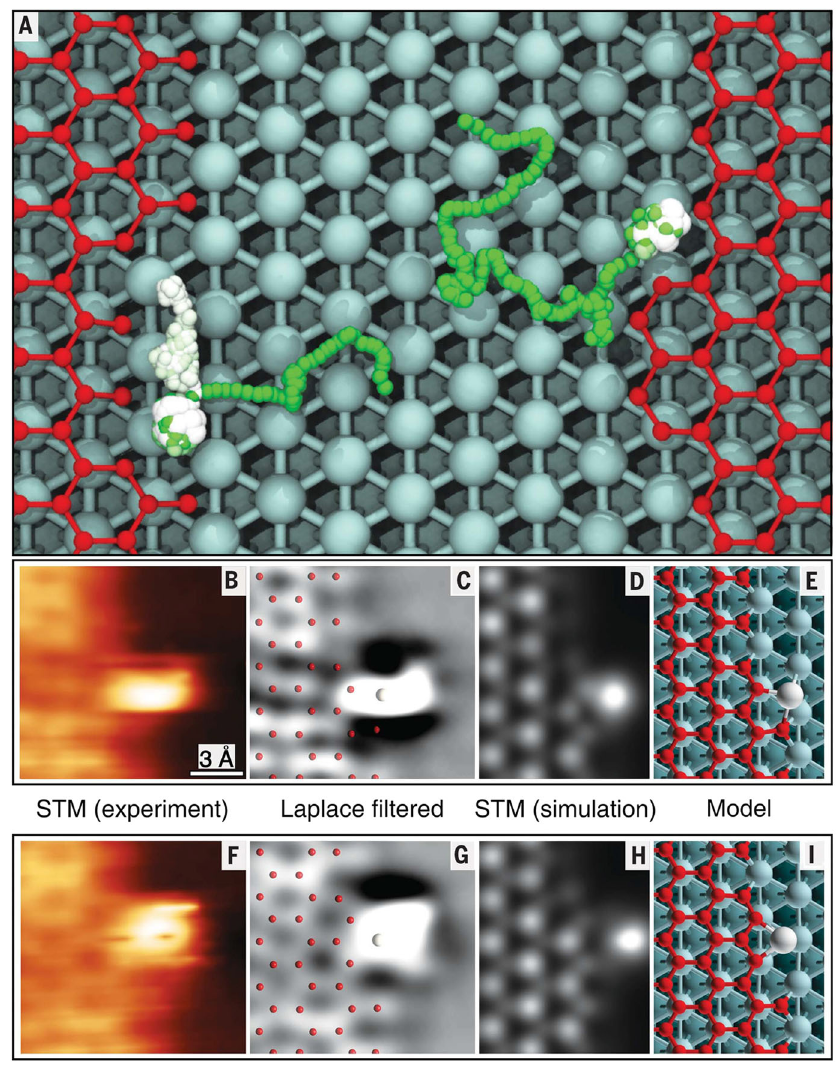
palette for Ni trajectories: from green (initial position) to white ( fi nal position). The fi nal steps are highlighted by increasing the ball size. B – I Short-lived con fi gurations of Ni adatom at k-edge kinks: B and F High-speed STM images from movie S2 (20) ( V = 20 mV; I = 7 nA). C and